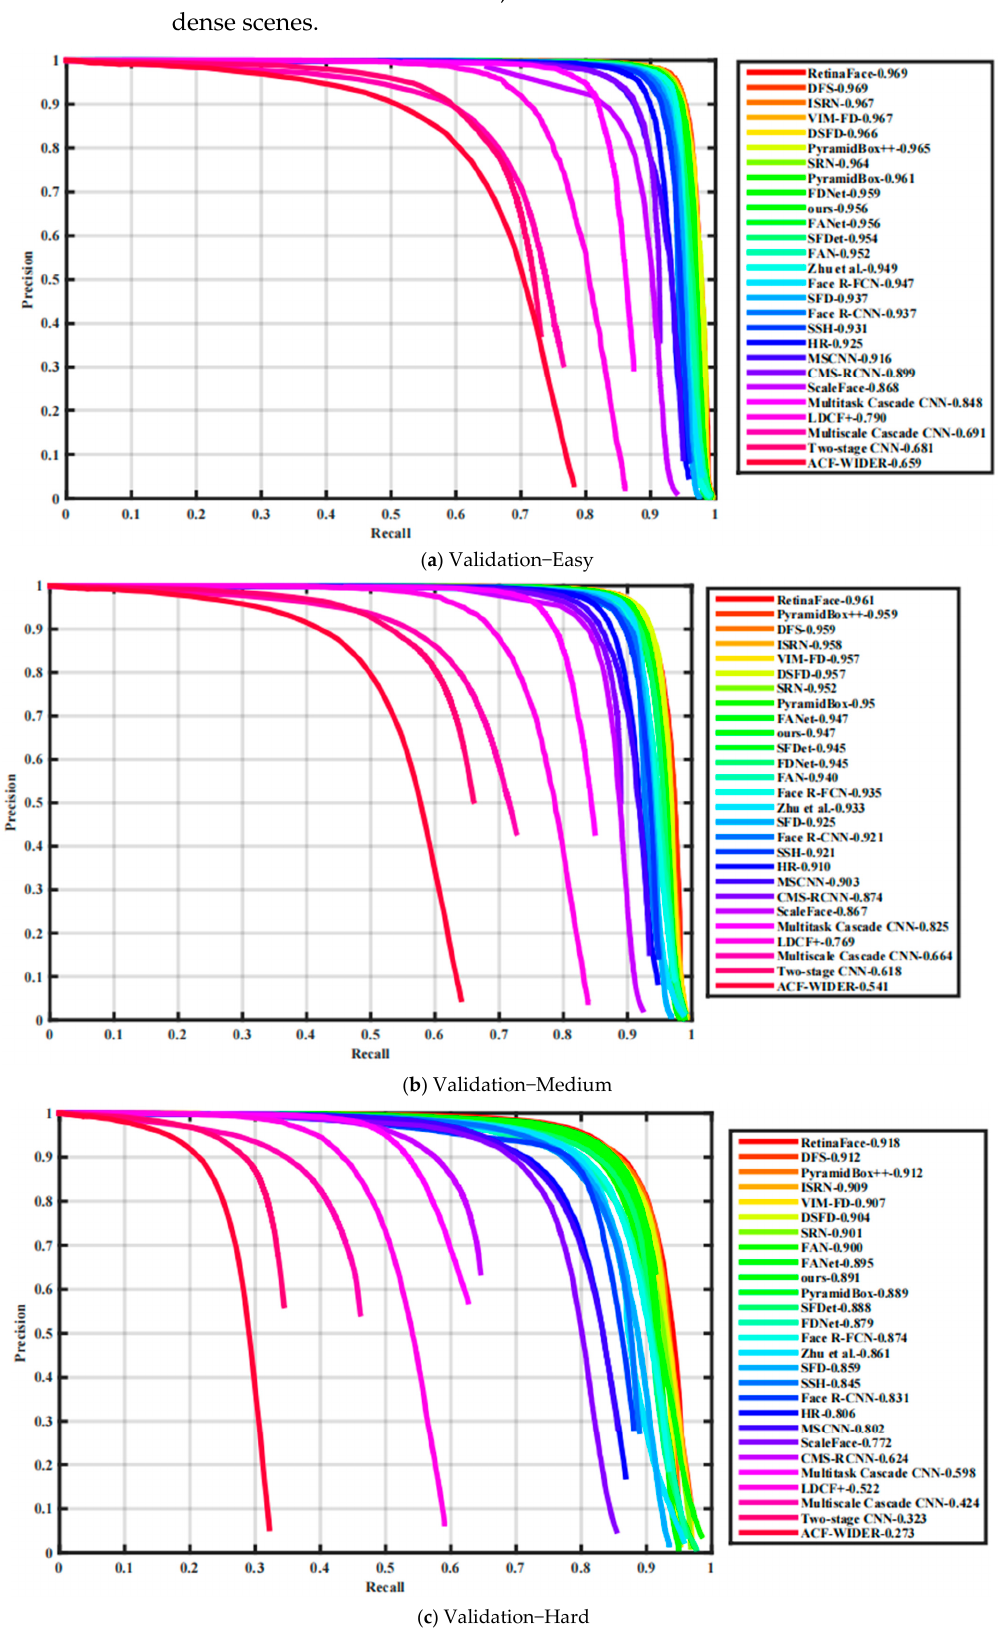
Figure 7. PR curves of the proposed and SOTA method (This is a comparison experiment with the advanced algorithm respectively on the easy, medium and hard data of the validation set).